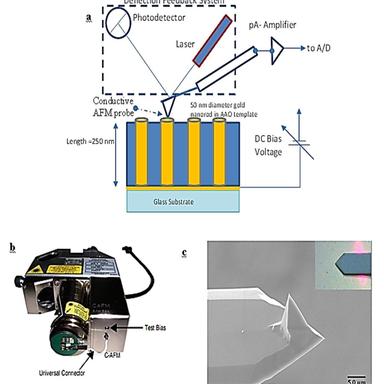
(a) Schematic diagram of the CAFM setup on single nanorods and Conductive AFM Block Diagram (b) Removable AFM scan head of the AFM (Bruker Dimension/Icon) including both CAFM application module and the special probe holder connected via a tiny wire. (c) SEM image of the standard Pt/Ir coated tip used for this series of experiments.